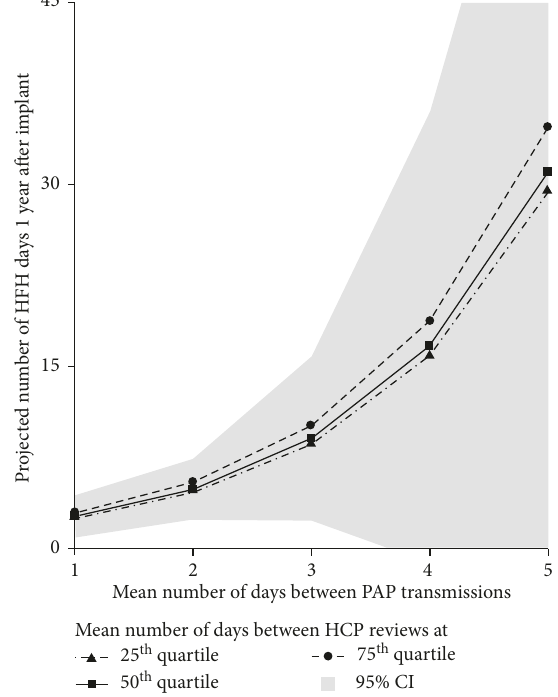
Figure 4: Heart failure hospitalization projections from the zero- inflated negative binomial model. Using these projections, this figure illustrates the exponential relationship between the number of HFH days a patient is projected to spend in the 1 year after sensor implant, based on the frequency of that patient’s transmissions of PAP data. Three separate projections are presented to demonstrate the impact of health care provider reviews. These projections were calculated at the 25 th /50 th /75 th quartiles of health care provider reviews of PAP data, which correspond to health care provider reviews at a mean of 4.4/6.3/10.3 days, respectively. The gray shaded area illustrates the 95% confidence interval for the projection made at the 50 th quartile of the health care provider review. HFH: heart failure hospitalization; PAP: pulmonary artery pressure; HCP: health care provider; CI: confidence interval.